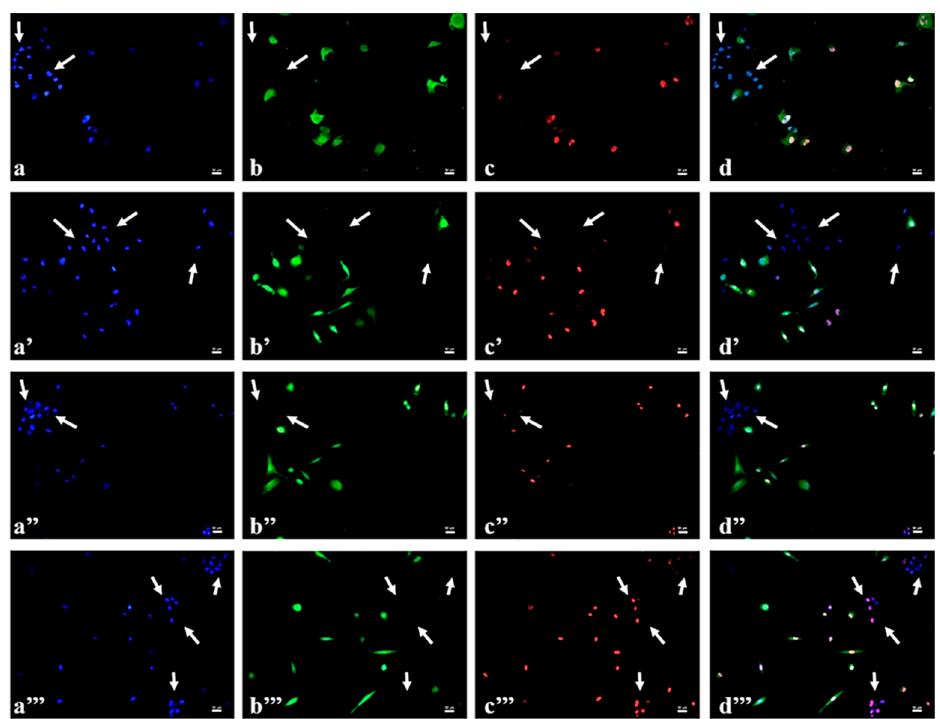
Figure 8. Fluorescence images of co-culture of HB2 (blue) and MDA-MB231 (blue and green) cells tween HB2 (breast healthy cells) and MDA-MB-231 (breast cancer cells). After 1 h of incu- incubated with p(NIPAM)-co-5%AA-co-FA-co-Dox (10 µM) (red) for 30 min ( a – d ); 1 h ( a’ – d’ ); 2 h ( a’’ – d’’ ), and 4 h ( a’’’ – d’’’ ). Blue: nuclei (DAPI); Green: MDA-MB 231 cells (CellTrace CFSE); Red: doxorubicin of p(NIPAM)-co-5%AA-co-FA-co-Dox microgels. Magnification 20×. Scale bar: 50 µm. doxorubicin of p(NIPAM)-co-5%AA-co-FA-co-Dox microgels. Magnification 20 × . Scale bar: 50 µ m.